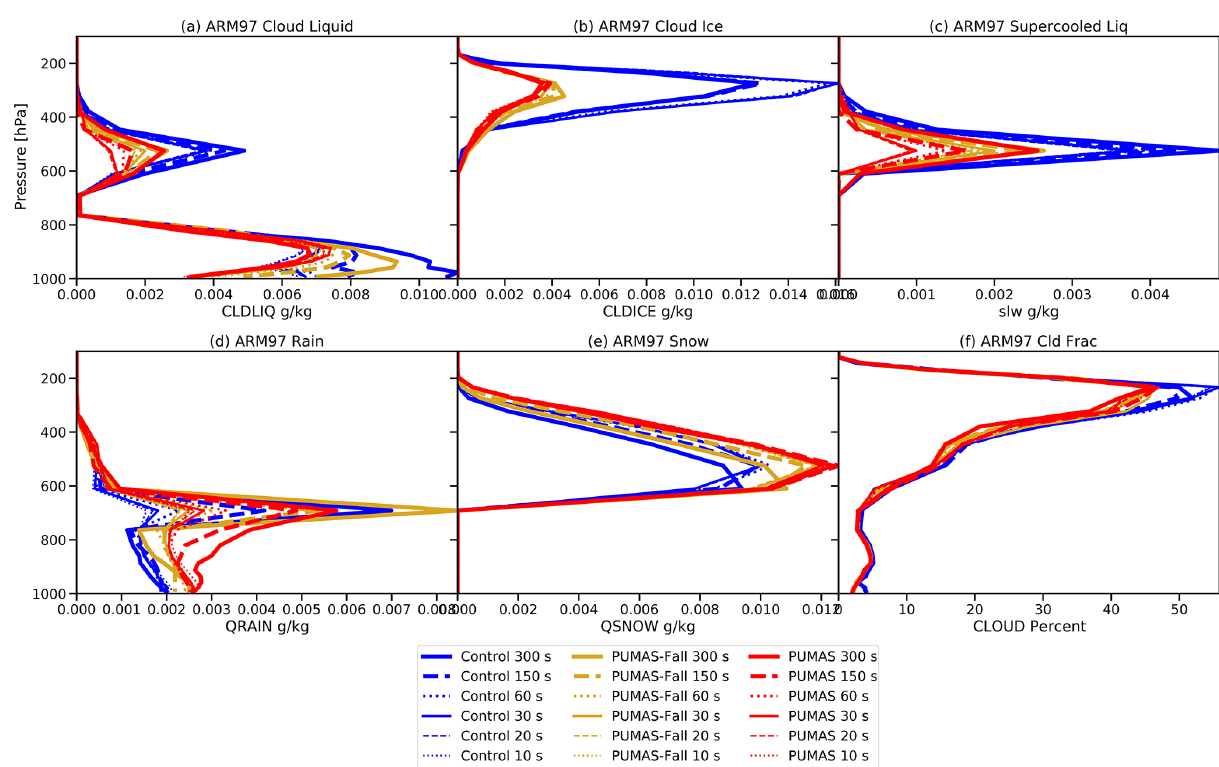
Figure 4. Time-averaged SCAM profiles from the ARM97 case with different time steps, as indicated in the legend. MG3 control cases (blue), PUMAS-Fall (orange), and PUMAS (red) are shown. Simulation names are defined in Table 1. Results are shown for (a) cloud liquid, (b) cloud ice, (c) supercooled liquid, (d) rain, and (e) snow mass-mixing ratios and (f) cloud fraction. Thicker lines indicate longer time